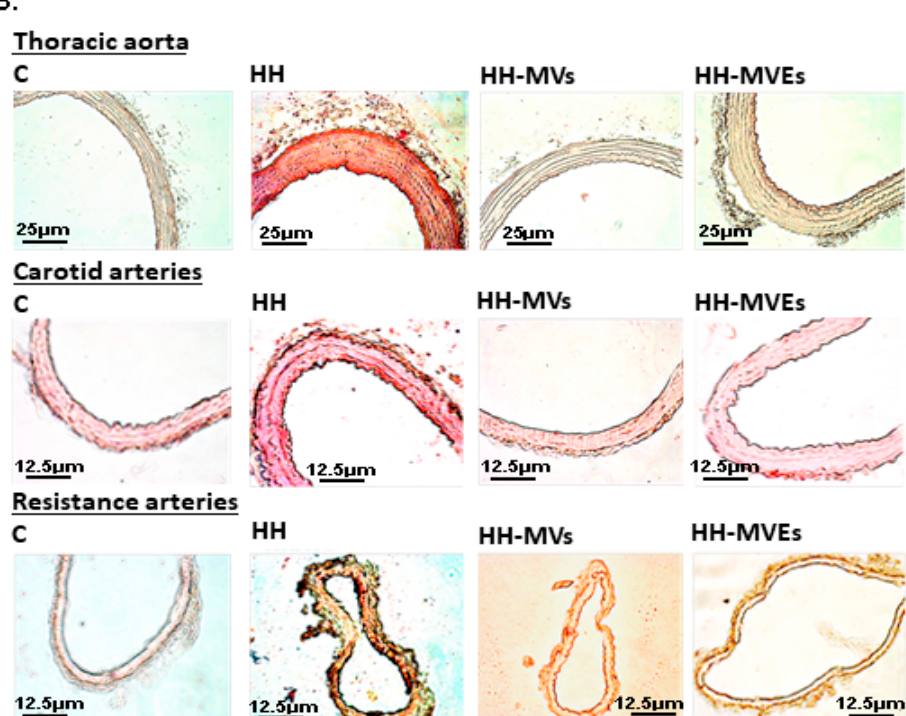
Figure 5. Structural changes of the vascular wall in the thoracic aorta, carotid artery, and resistance artery isolated from the C, HH, HH-MVs, and HH-MVEs groups ( n = 5 individual animals per group): ( A ). The evaluation of morphology of the arterial wall by hematoxylin-eosin staining; ( B ). The representative micrographs showing oil-red O-stained lesions.